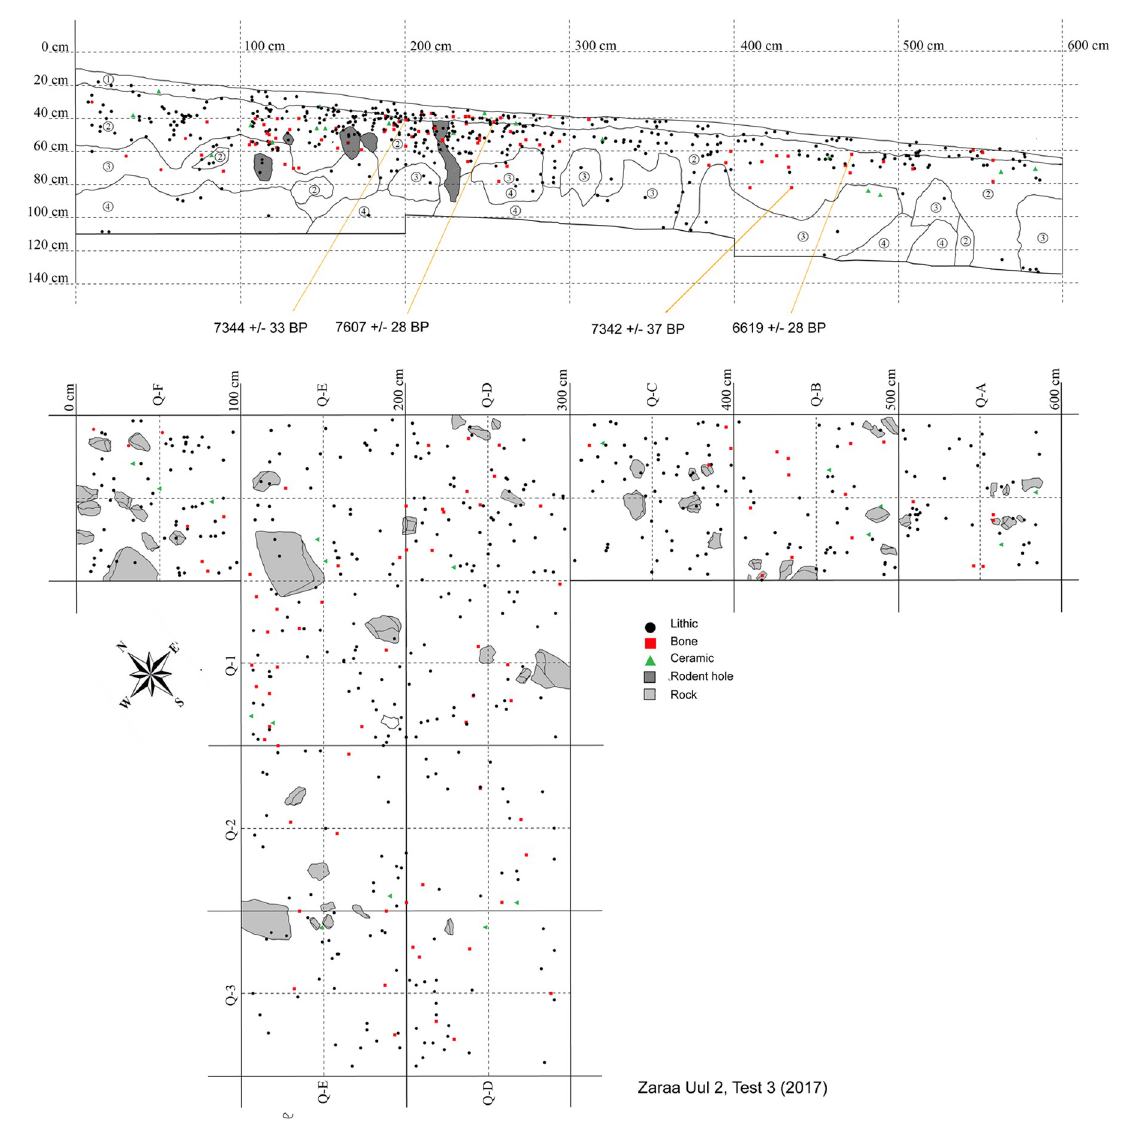
Fig 5. Map of 2017 excavation at Zaraa Uul, Locus 2